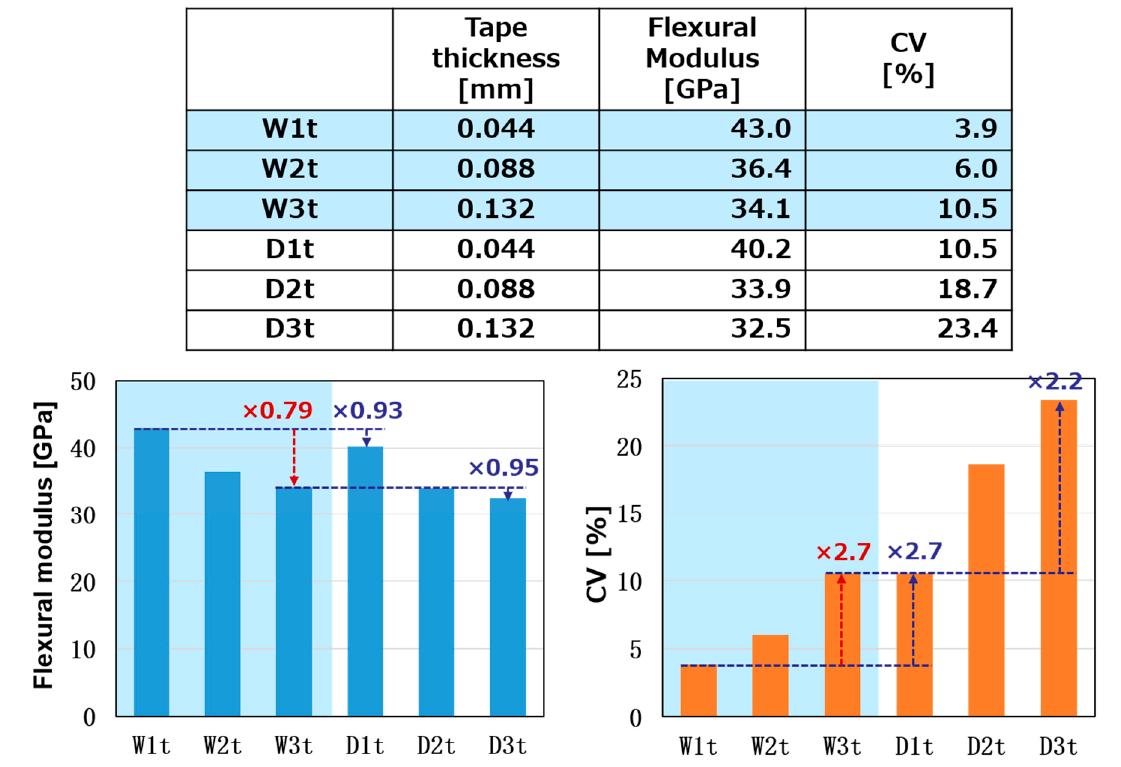
Figure 9. Effects of tape morphology and fabrication process on the mechanical properties of the CTT.